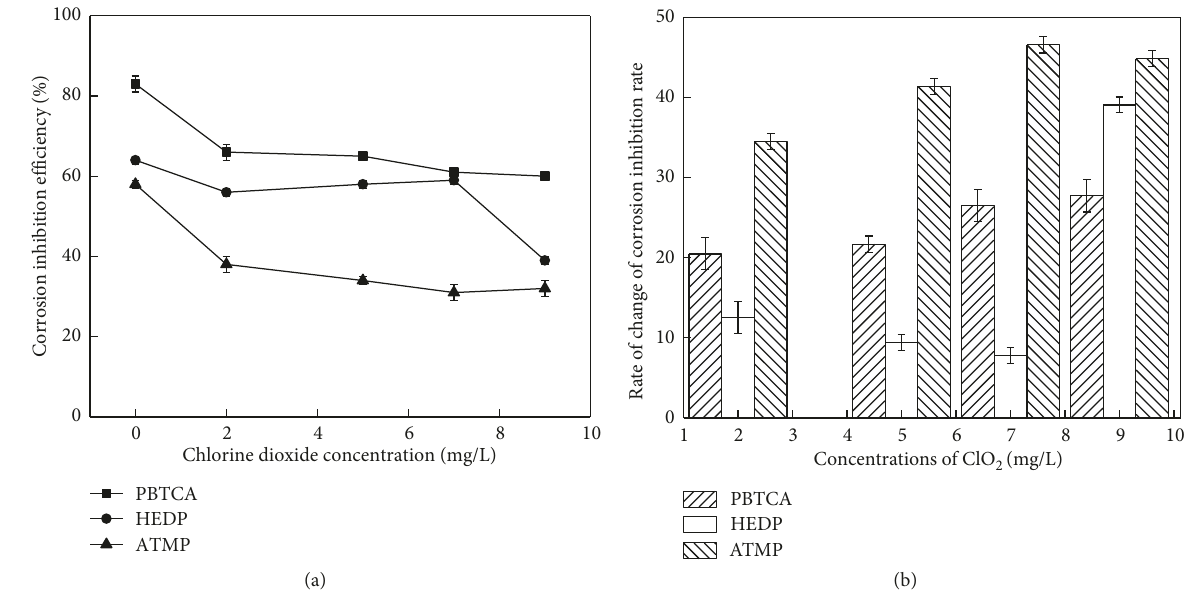
Figure 3: (a, b) Corrosion inhibition rate of carbon steels with different concentrations of ClO